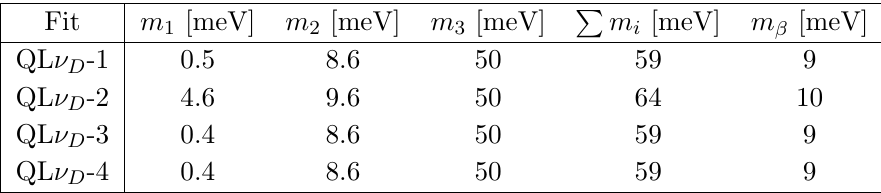
Table 7 . Predictions for neutrino masses and observables for the NO (cid:12)ts in table 6. Quantity Range [meV] Preferred values [meV] P m i